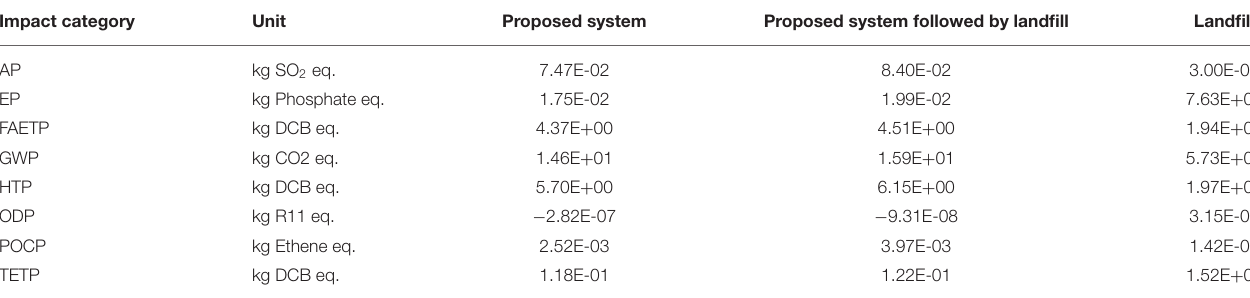
TABLE 5 | Comparison of proposed system, landfill following proposed system, and landfill. Impact